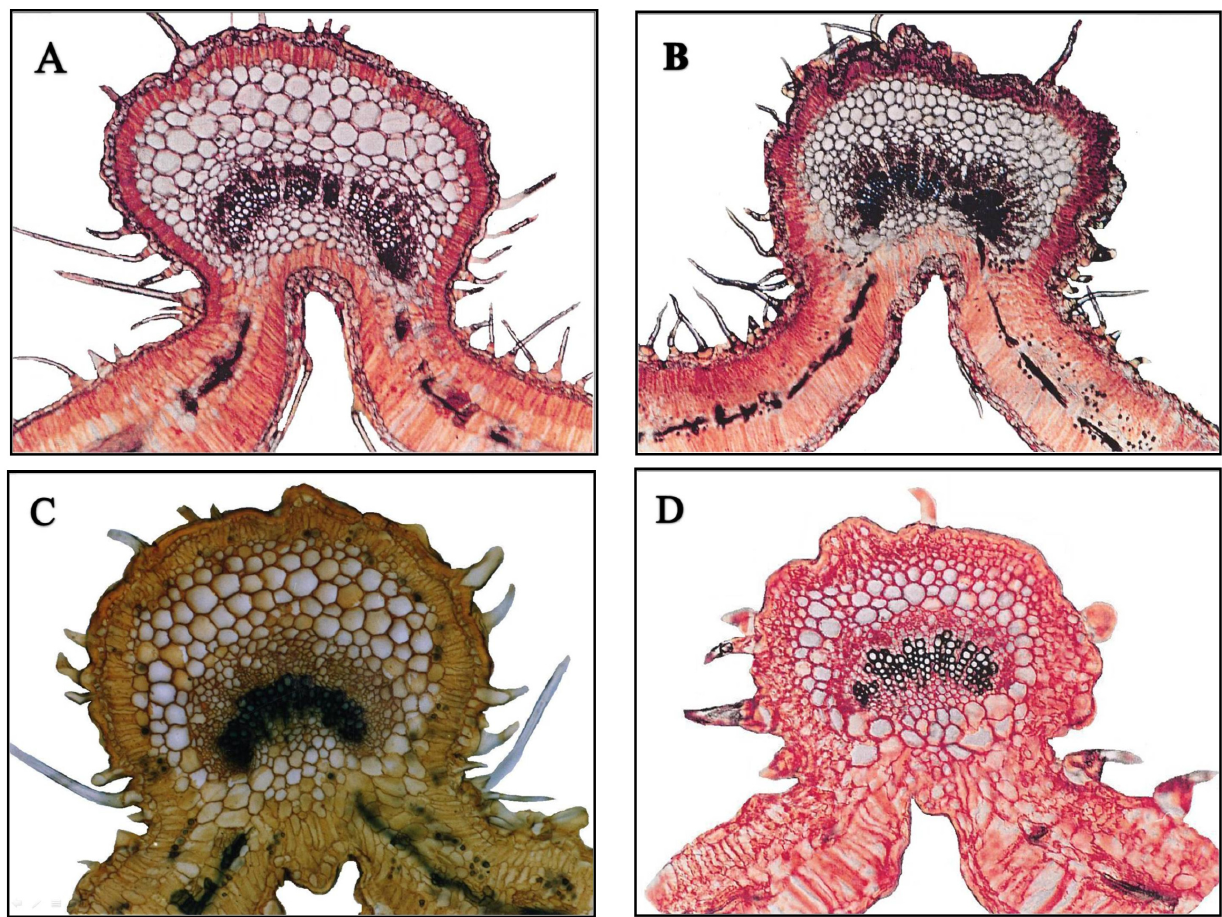
Fig. 2. Midrib of Heliotropium species in T.S; H. transoxanum (A); H. dasycaypum (B); H. digynum (C); H.ellipticum